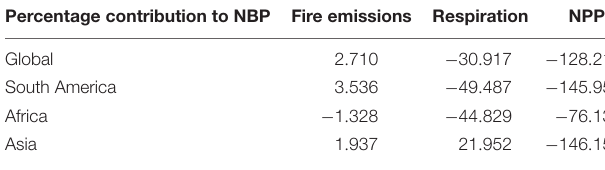
TABLE 3 | Percentage contribution of variables to